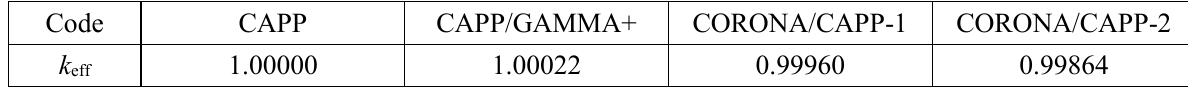
Table II. Multiplication factors for single column problem.